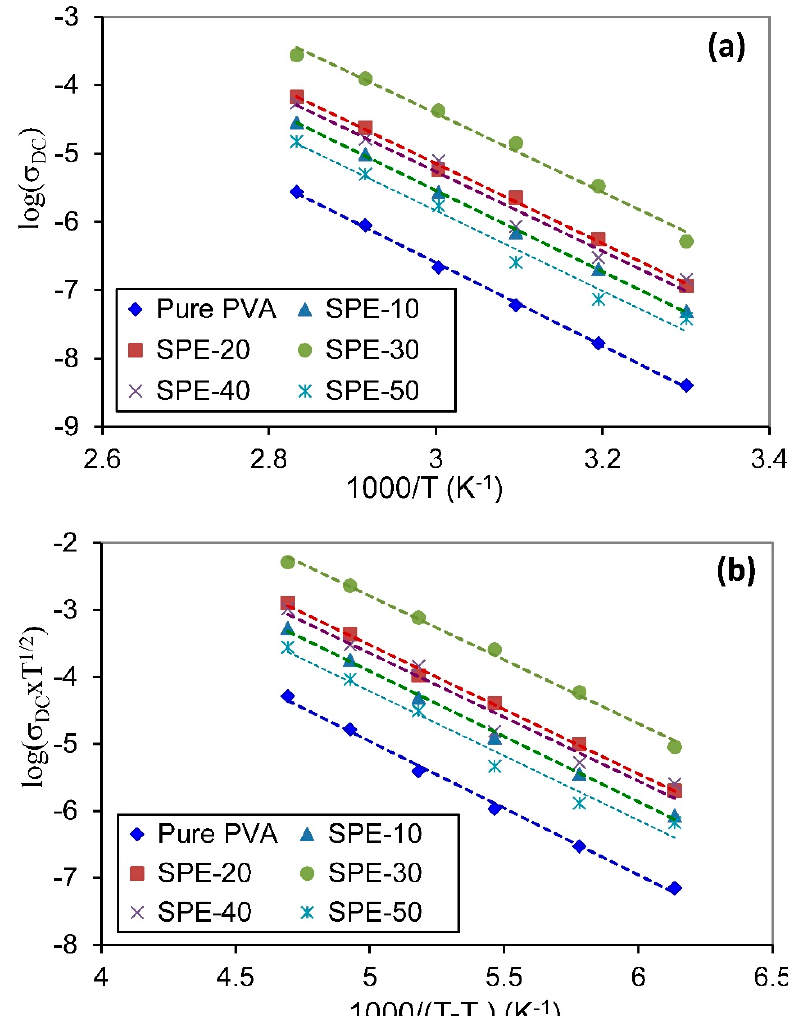
Figure 9. Temperature-dependence of DC conductivity for pure PVA and all PVA/NH 4 NO 3 proton- conducting SPE films doped with various concentrations of NH 4 NO 3 , using ( a ) Arrhenius and ( b ) Vogel–Tammann–Fulcher (VTF) models. Table 2. Parameters determined through experimental data fitting using Arrhenius and Vogel– Tammann–Fulcher (VTF) models.